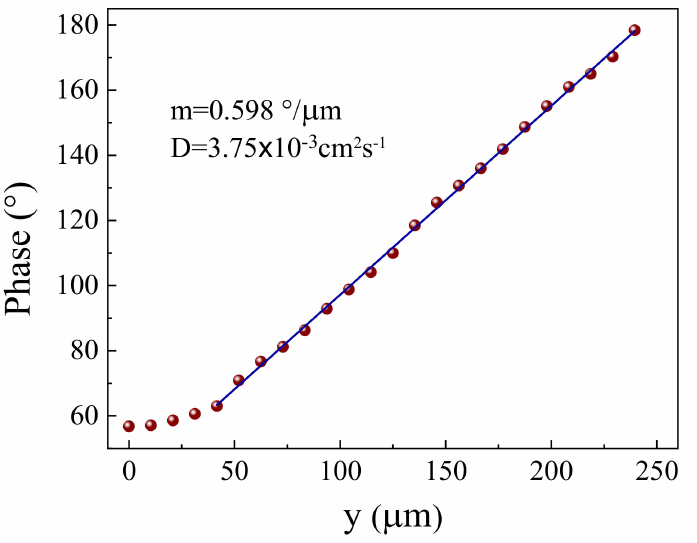
Figure 9. Phase of the transverse component of the perpendicular deflection versus the pump to probe offset y for the PMZE + 0.6 TiO 2